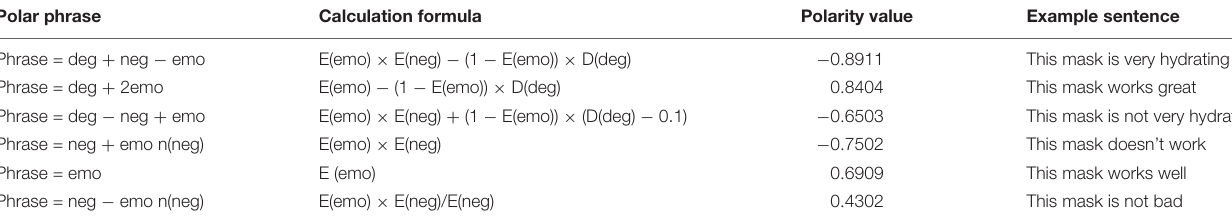
FIGURE 1 | Ranking of e-commerce brand user activity. TABLE 2 | Sentiment calculation rules for polar